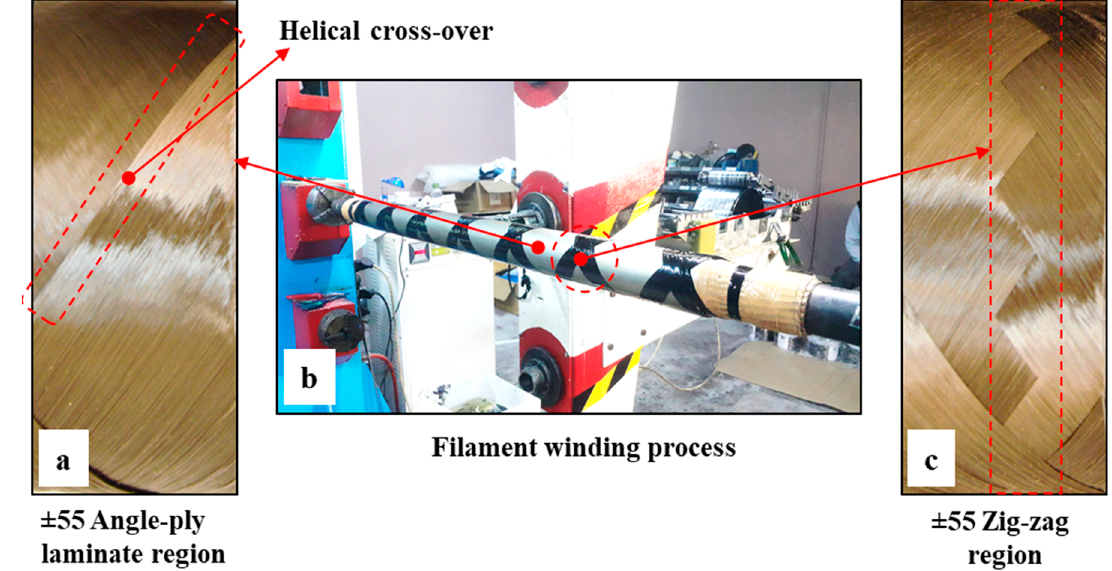
Figure 1. BFR/EP filament winding composite pipes: ( a ) ±55 angle-ply laminate region, ( b ) filament winding process, and ( c ) ±55 zigzag region.